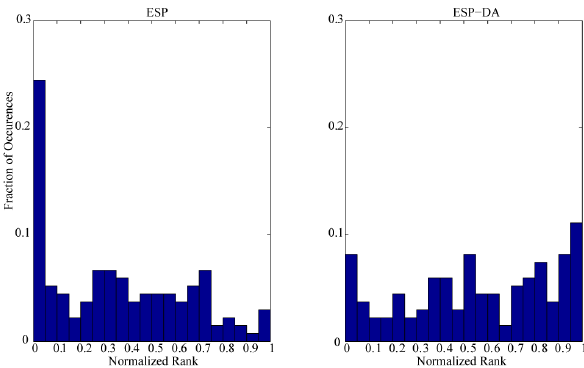
Fig. 9. Rank histogram of the seasonal volumetric flow prediction for all 15 basins beginning in March, April and May during 2003, 2004 and 2005.